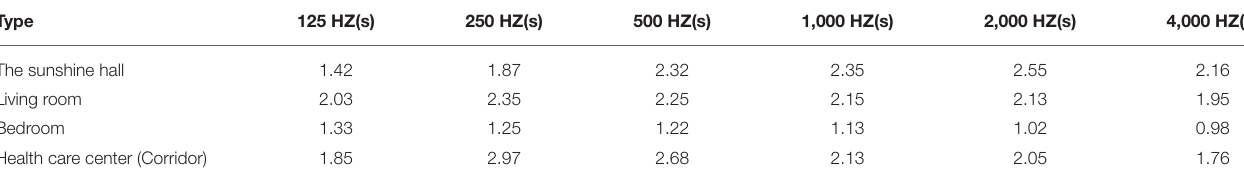
TABLE 3 | RT at different frequencies in public